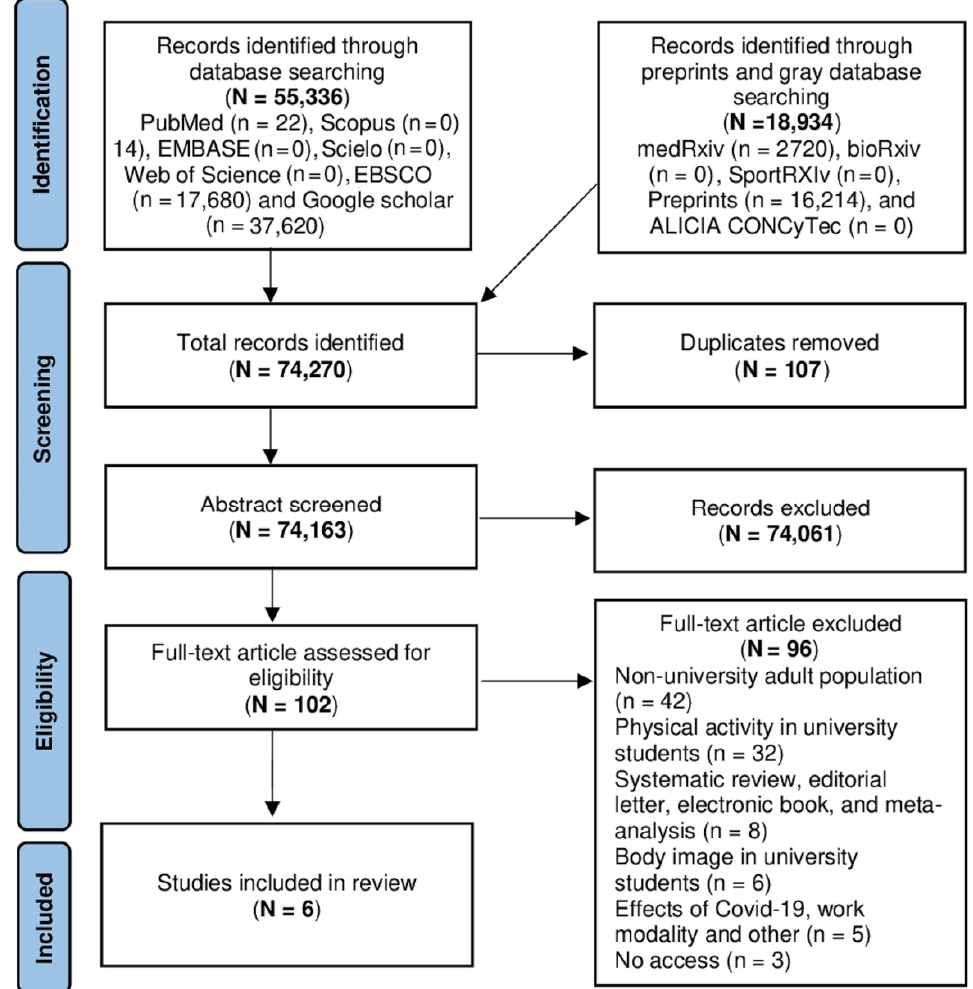
Figure 1. PRSIMA flowchart of the studies.